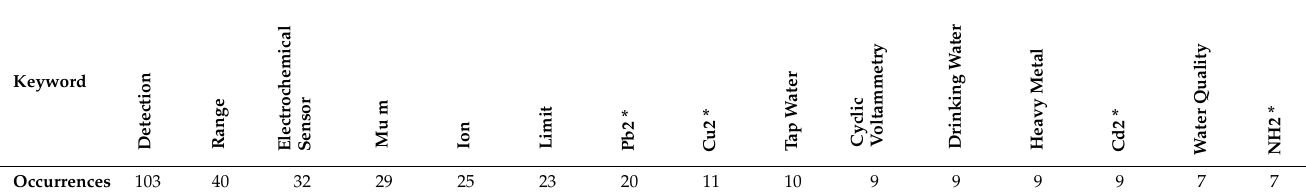
Table 5. Cluster 2 keywords and occurrences.